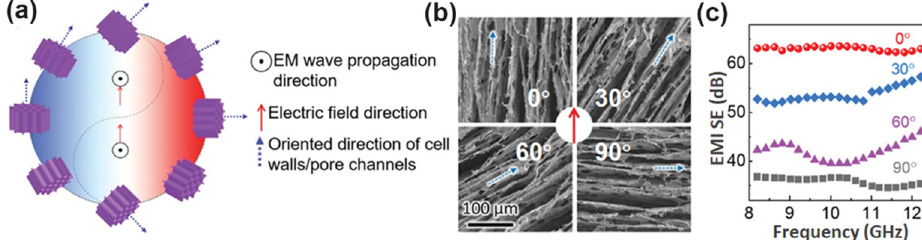
Figure 17. ( a ) Schematic illustration of the cell walls’/pore channels’ orientation-induced EMI shielding mechanism. ( b ) SEM images and ( c ) EMI shielding effectiveness of the MXene/CNF hybrid aerogels with various angles between the cell walls’ oriented direction and electric field direction of incident EM waves. Reproduced with permission from ref. [59]. Copyright 2020, Wiley-VCH.